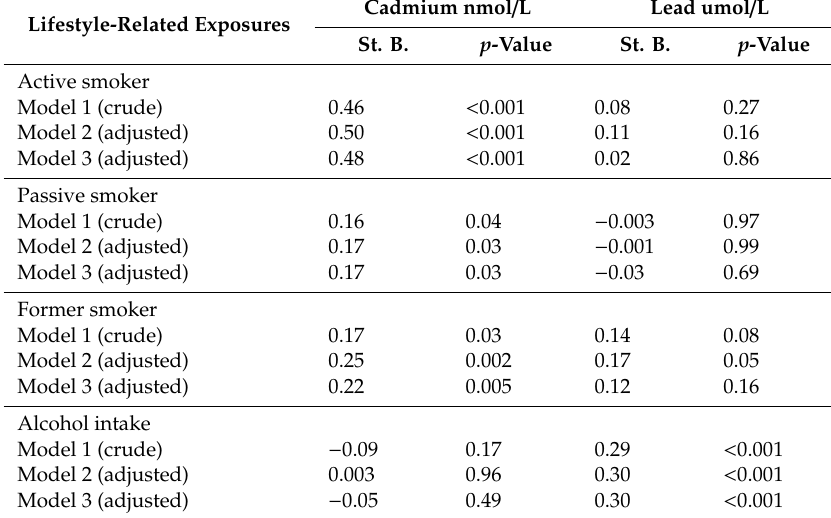
Table 2. Multivariate linear regression analyses on smoking status and alcohol intake and Cd and Pb